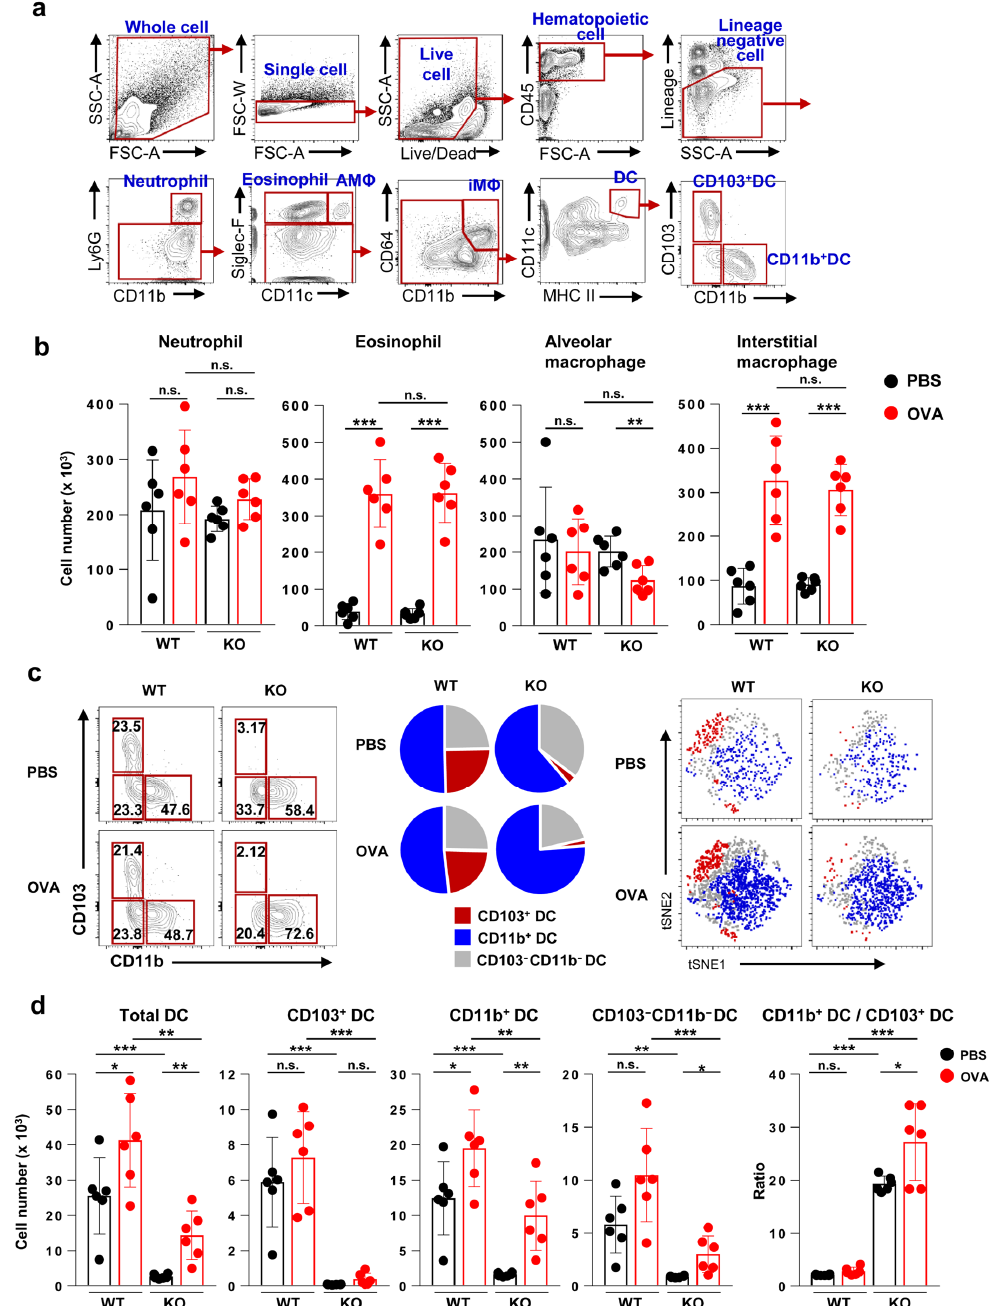
Figure 3 Figure 3. Analysis of myeloid cell compositions and characteristics of dendritic cell (DC) subsets in the lungs of wild-type (WT) and Flt3 knockout (KO) mice. ( a ) Representative flow cytometry